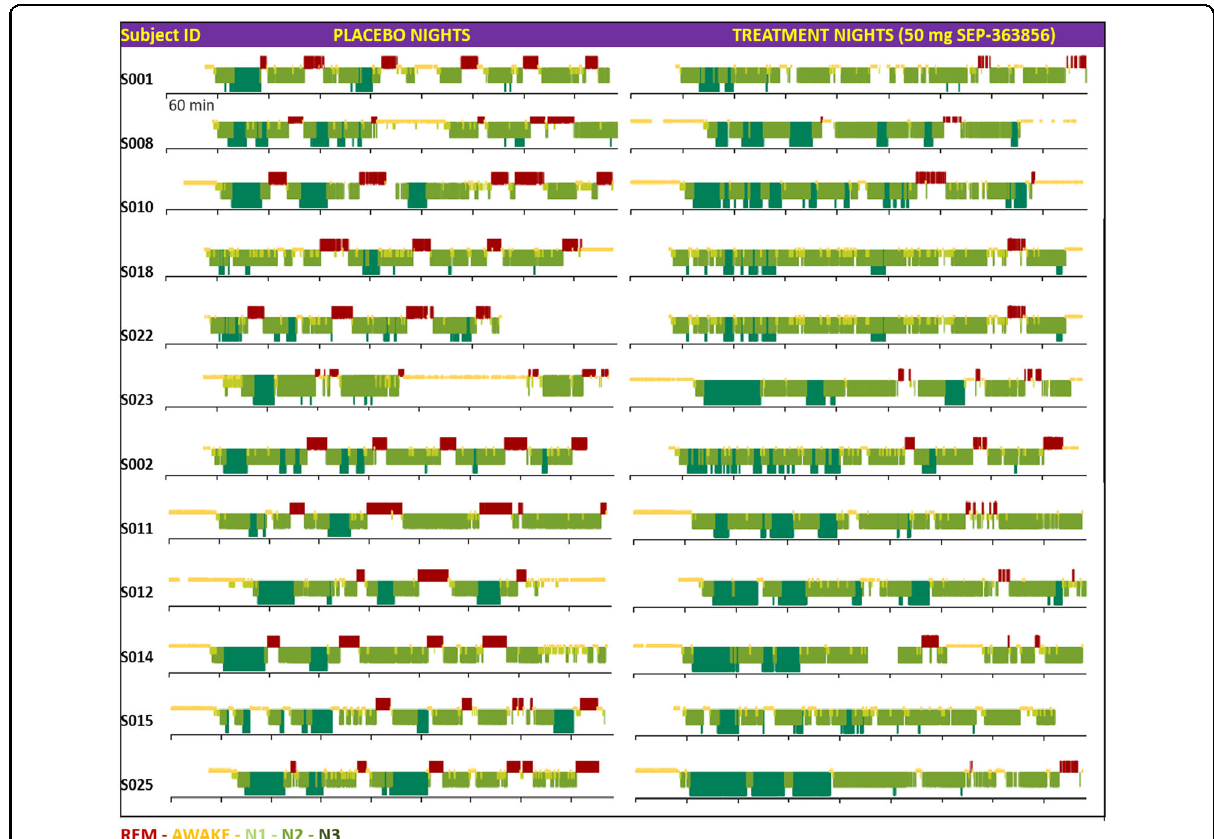
Fig. 3 Individual hypnograms from all 12 subjects following crossover treatment with 50 mg SEP-363856 or placebo. SEP-363856 potently suppressed REM sleep and increased the latency to REM sleep across all